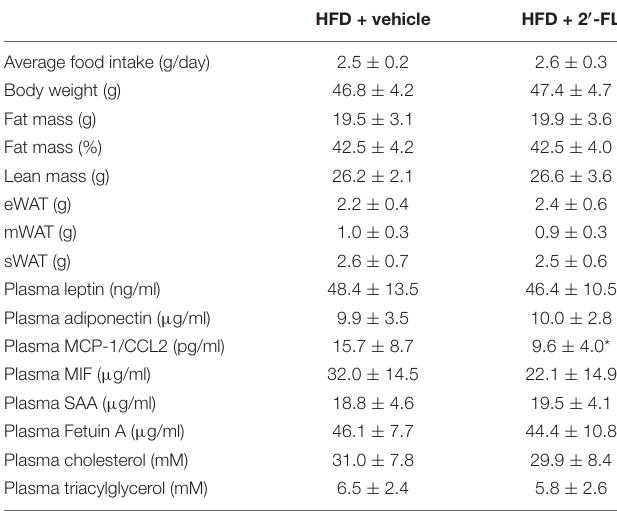
TABLE 1 | Body composition, energy intake and metabolic and inflammatory parameters after 28 weeks.